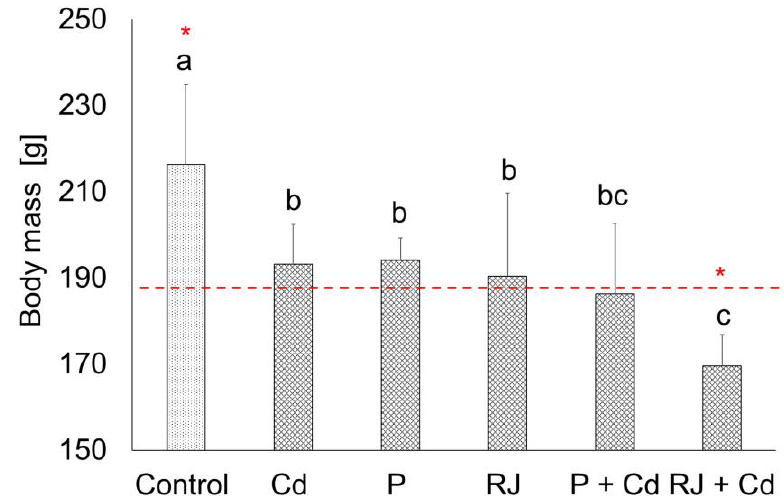
Figure 2. Final body mass [g] of females after exposure to Cd, P, RJ, and a combination of P or RJ with Cd (P + Cd or RJ + P). The same letters denote homogenous groups. The asterisks above bars indicate significant differences between the initial (red line) and final (bar) body mass in each group (ANOVA, HSD Tukey test, p < 0.05). The average initial body mass was 183.27 ± 13.36. Cd—cadmium group where rats were receiving Cd as CdCl 2 (4.5 mg/kg/day) during the experiment, P—propolis group where animals were treated with propolis (50 mg/kg/day), RJ—royal jelly group where animals were treated with royal jelly (200 mg/kg/day), P + Cd—combined treatment group where animals were pretreated with propolis for one week and then treated simultaneously with propolis and cadmium, RJ + Cd—combined treatment group where animals were pretreated with royal jelly for one week and then simultaneously treated with royal jelly and